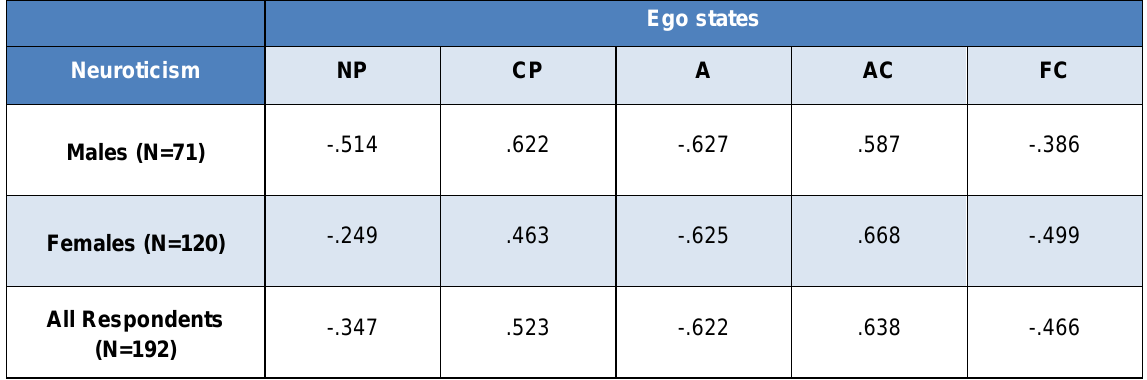
Table 3: Correlations between ego states and Neuroticism (All respondents)